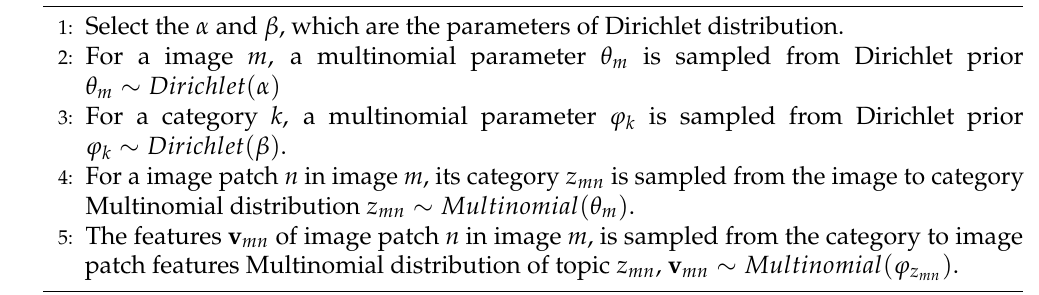
Figure 3. Graphical model of traditional LDA. Algorithm 1 Generative process of